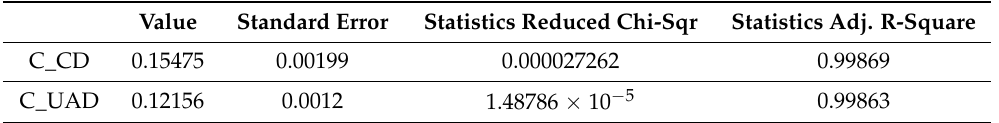
Table 3. Calibrated results of the coefficient C in Equation